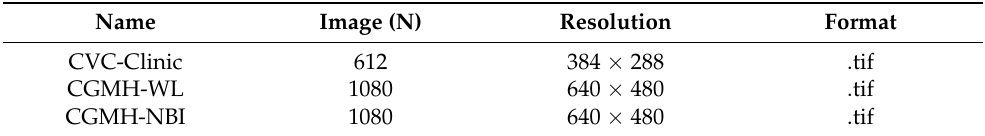
Table 2. Experiment data set.